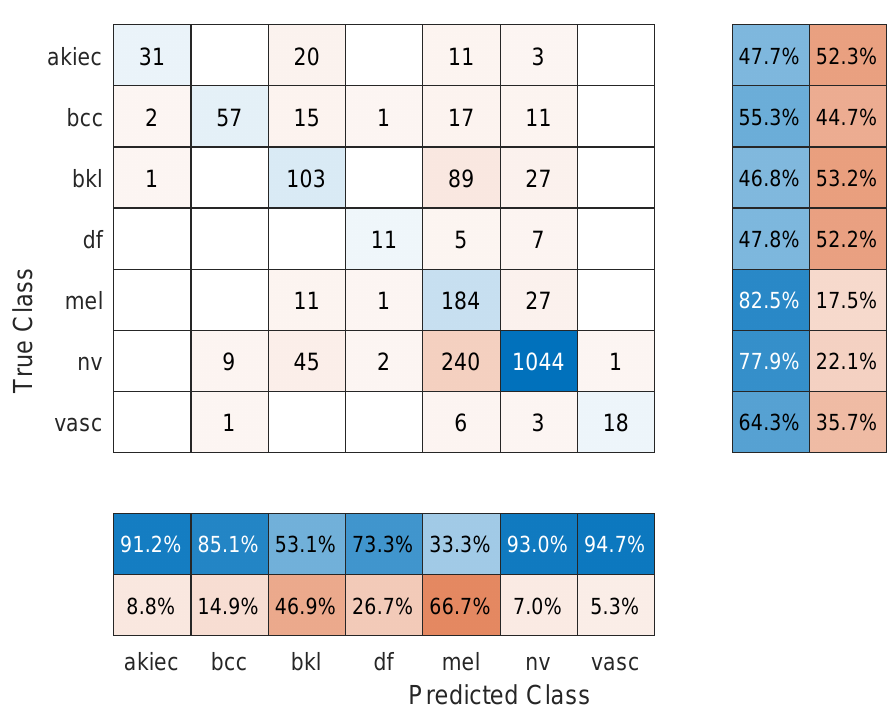
Figure 9. Sample confusion matrix for DenseNet201 model, 80/20 data split and 50 epochs of